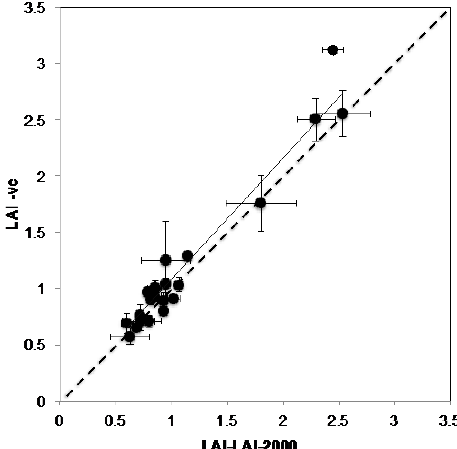
Figure 5. Relationship between the canopy size measured using the Licor-2000 (LAI-LAI-2000) and VitiCanopy App (LAI-vc e ) for three vineyards located in Langhorne Creek (SA), Hilltops (NSW) and Sunraysia (Vic) during the season 2013–14. Error bars correspond to the standard error of the means. The continuous line represents the calculated regression passing through the origin (0,0), the dashed line represents the 1:1 relationship.